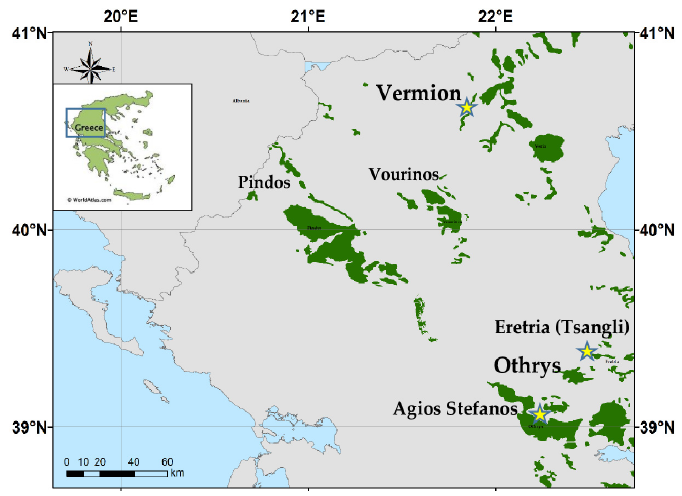
Figure 1. Location of the major ophiolites in central-north Greece, including Vermion and Othrys complexes, showing the deposits in which the new minerals have been discovered (yellow stars).